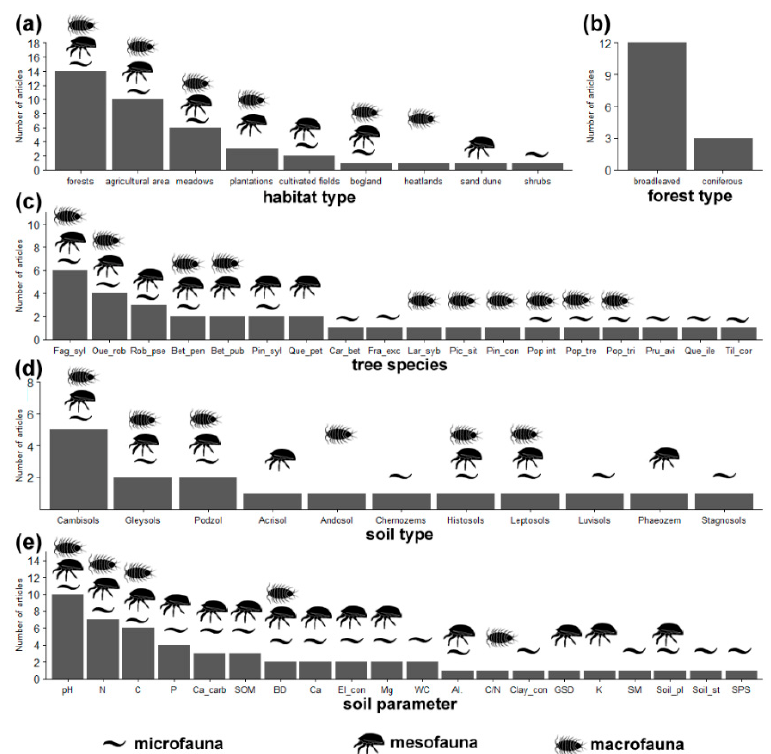
Figure 1. Habitat types ( a ), forest types ( b ), tree species ( c ), soil types ( d ) and soil parameters ( e ) reported from publications on post-agricultural sites. Tree species abbreviations are based on the first three letters of the genus and species name of the tree species. Soil parameter abbreviations